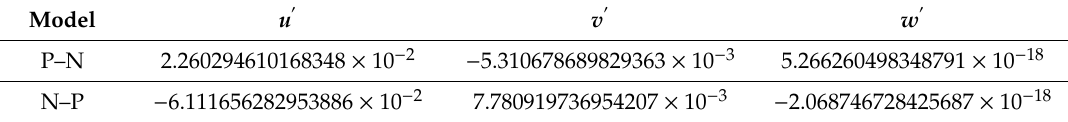
Table 1. Velocity comparison. P–N—positive–negative;